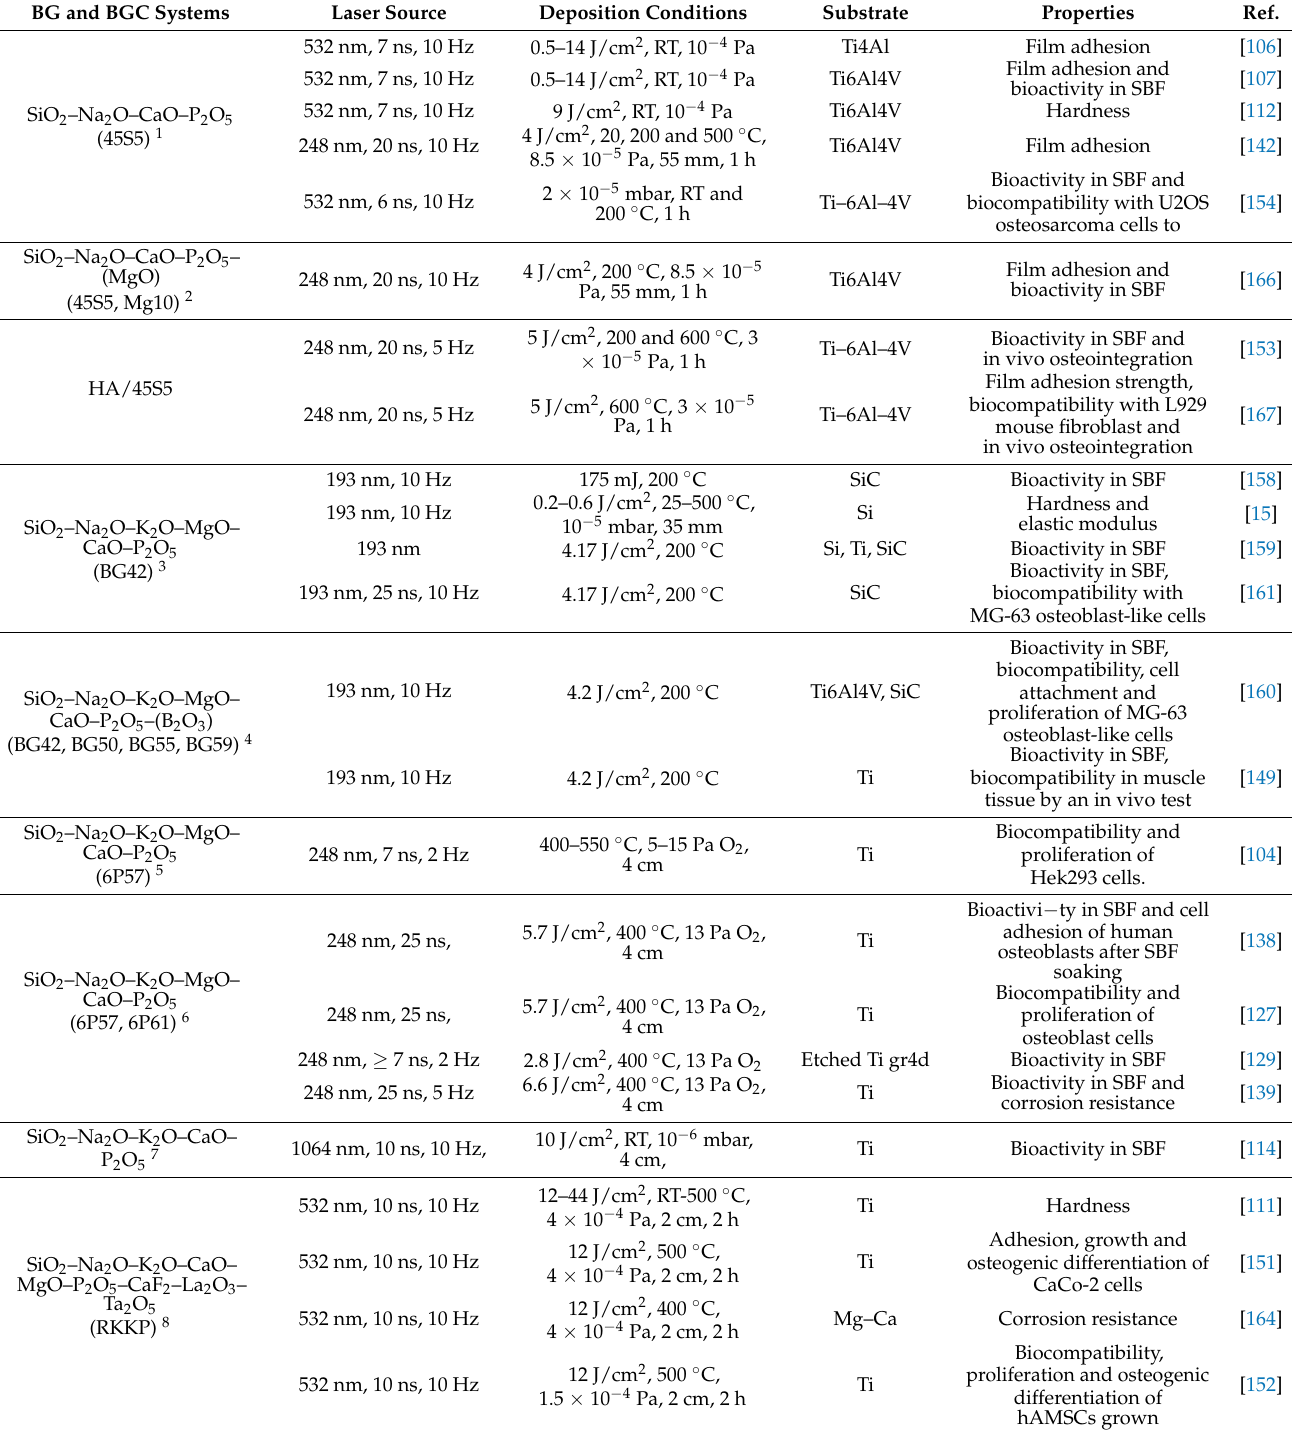
Table 3. Pulsed laser deposition (PLD) experimental details and investigated properties of films of BG and BGC. BG and BGC